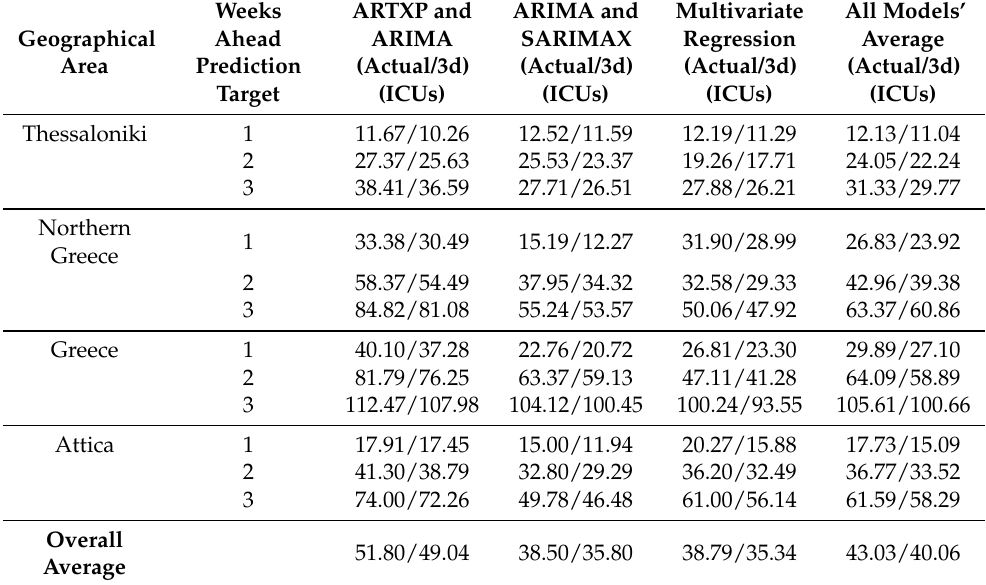
Table 5. MAE of Predicted vs. Actual